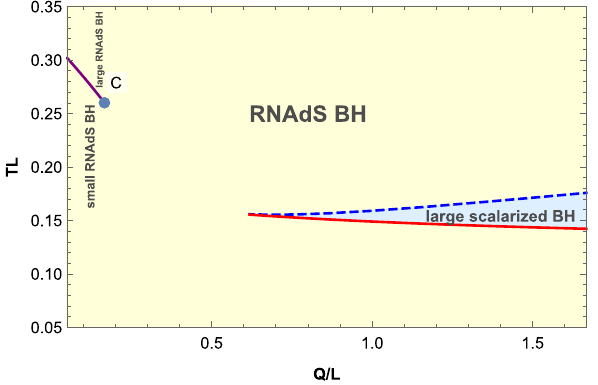
Fig. 5 PhasediagramofRNAdSandscalarizedblackholesinacanon- ical ensemble with fixed temperature T and charge Q . Here, we take α = 5. The phase diagram exhibits the globally stable phases, which have the lowest free energy, and the phase transitions between them. The light yellow and blue regions correspond to RNAdS and scalarized black holes, respectively. A first-order phase transition line (the purple line) separates the large RNAdS BH phase, which is above the line, and the small RNAdS BH phase, which is below the line. The first-order phase transition line terminates at the critical point, labelled by C . The scalarized black hole phase is delimited by a zeroth-order phase tran- sition line (the red line) and a second-order one (the blue dashed line), which coincides with the bifurcation